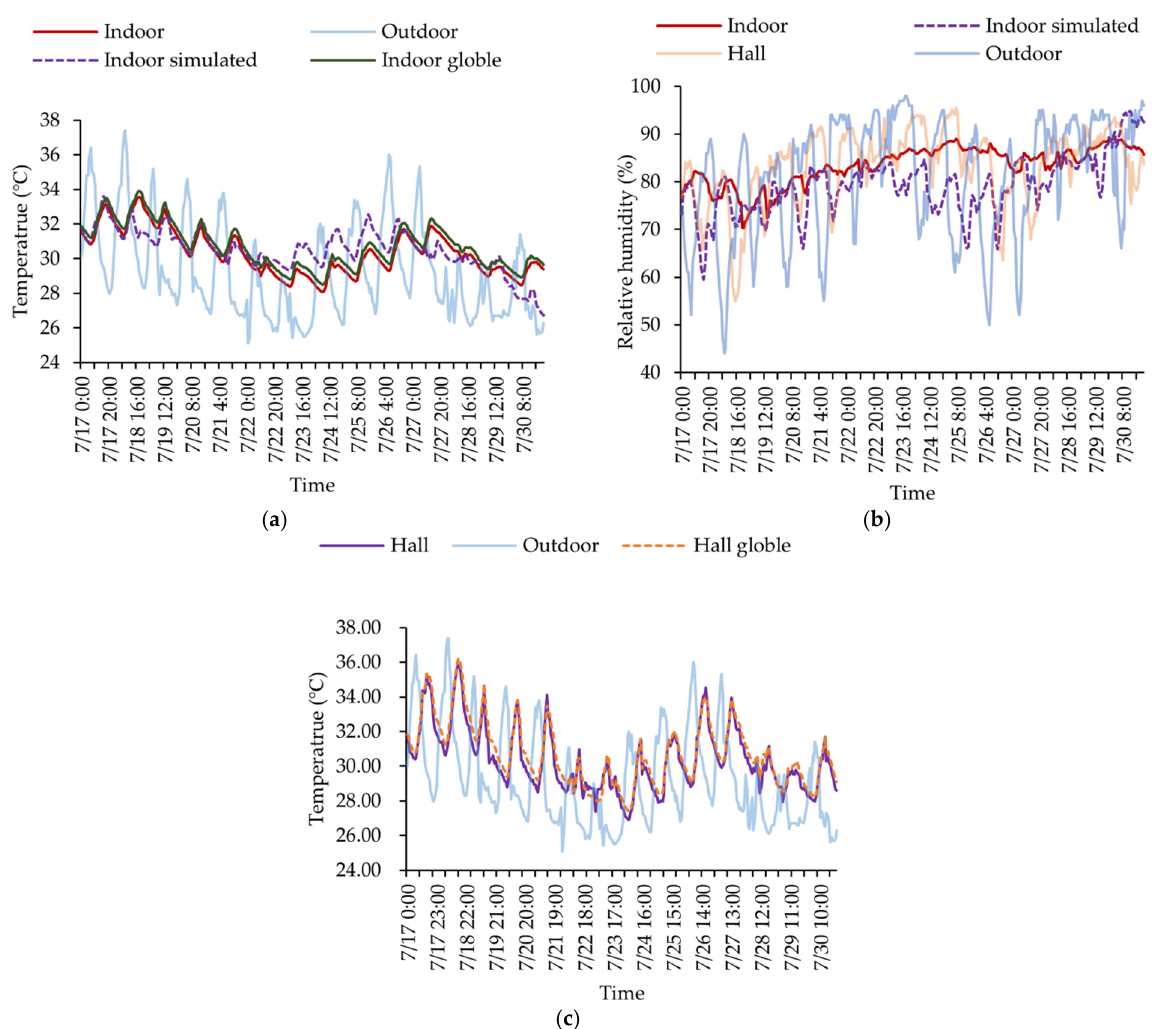
Figure 6. Comparison of measured and simulated values in summer: ( a ) Indoor temperature; ( b ) Relative humidity; ( c ) Hall temperature.